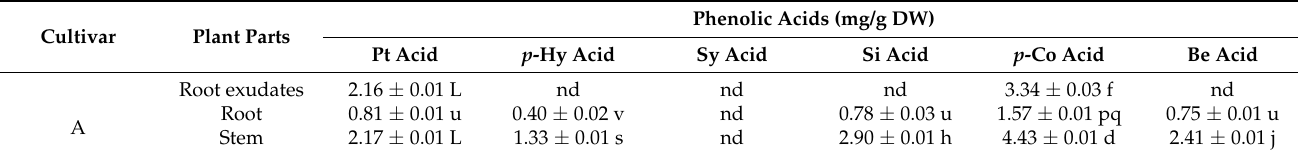
Table 5. Phenolic compounds in different extracts of sweet